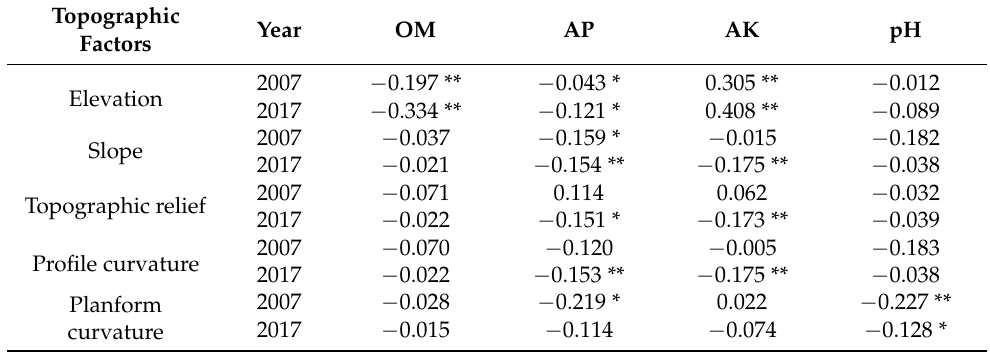
Table 5. Pearson’s correlation between topographic factors and soil chemical properties in Hefeng. Topographic Factors